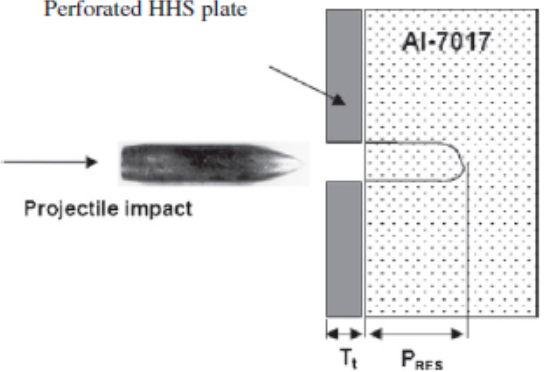
Figure 11. Target configuration studied in [47]. Reprinted with permission from Elsevier: Mater. Des.